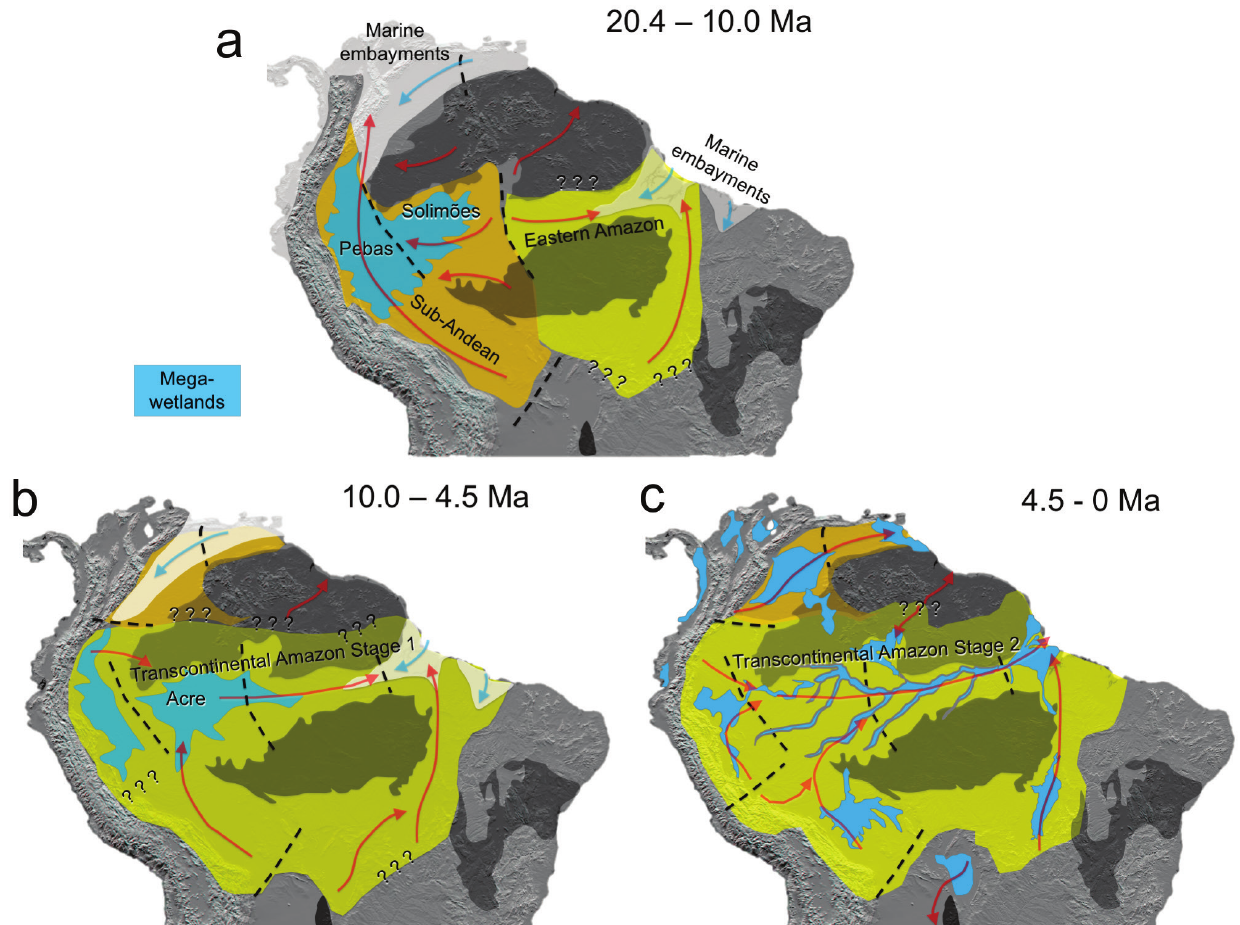
Fig. 4. The changing courses of rivers in northern South America through the Neogene. Reconstructions based on pale- ogeographic history of major sedimentary basins. a. Early and Middle Miocene (20.4-9.0 Ma). North-trending Sub-An- dean river basin orange; east-trending Eastern Amazon river basin yellow. b. Late Miocene (9.0-5.3 Ma). East-trending transcontinental Amazon river basin (Stage 1). c. Middle Pliocene – Recent (c. 4.5-0 Ma). East-trending transcontinental Amazon river (Stage